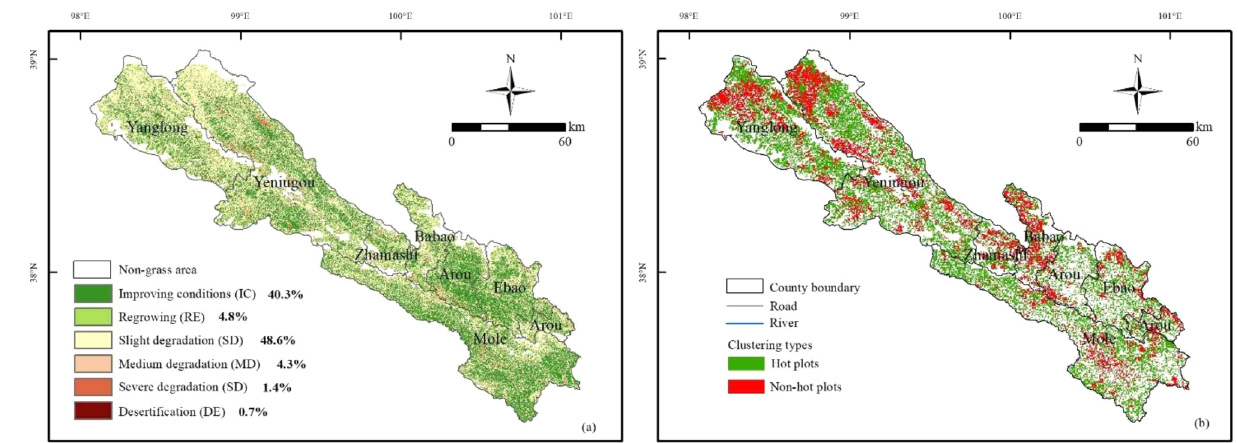
Figure 3. Spatial variation of grassland degradation or restoration for the 2000–2019 period. The map was generated by ArcGIS 10.2, URL: https:// www. esri.